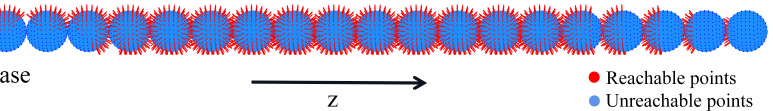
Figure 8. The reachability spheres of some continuous sub-workspaces, which represent the direction preference of the